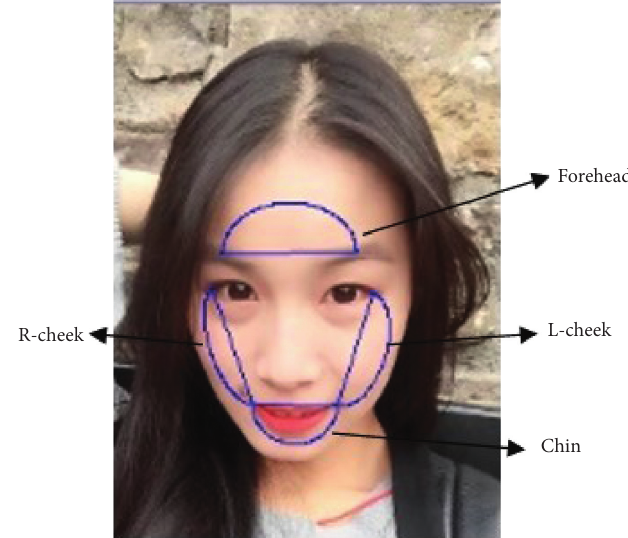
Figure 5: The distribution possibility for input in SCE. Table 1: A control factor table that may be generated for the colour detection.